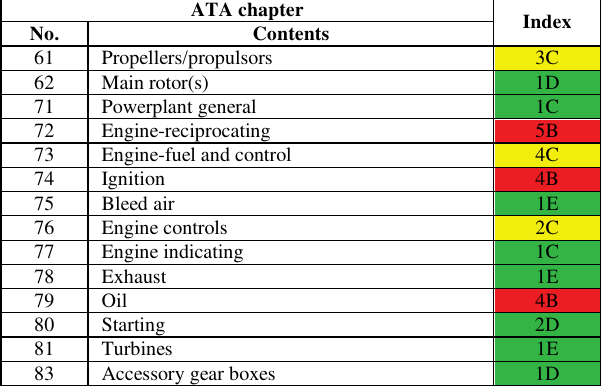
Fig. 6. Flight phases share when piston engine malfunction took place